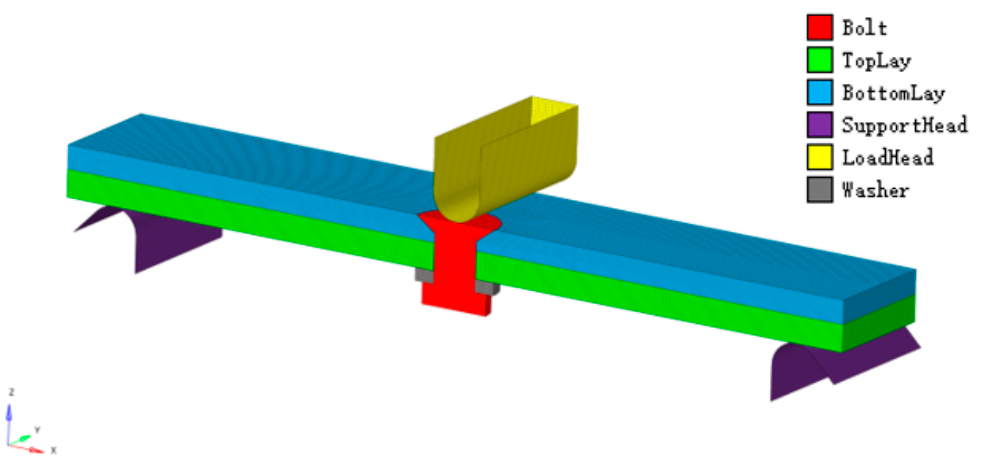
Figure 6. Simulate analysis FEA model mesh